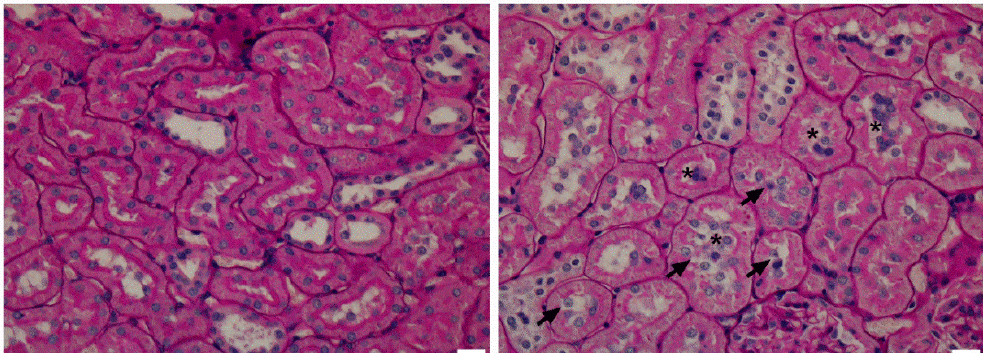
Figure 1. Histological images of representative periodic acid Schiff (PAS) stained kidney sections (400 × , scale bar represents 20 µ m). PAS stained kidney sections of a rat from Control ( left ) and HFD ( right ) group showing greater evidence of missing or ruptured brush border (arrows) and cell sloughing inside the lumen (asterisk) in offspring of HFD fed fathers compared to Control.